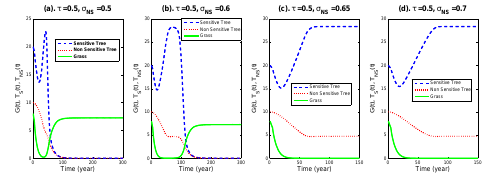
Fig. 7. From grassland to forest as a function of the grass vs. non sensitive-tree competition parameter σ NS . From left to right, the fire period τ is fixed, while the grass vs. non sensitive-tree competition parameter σ NS